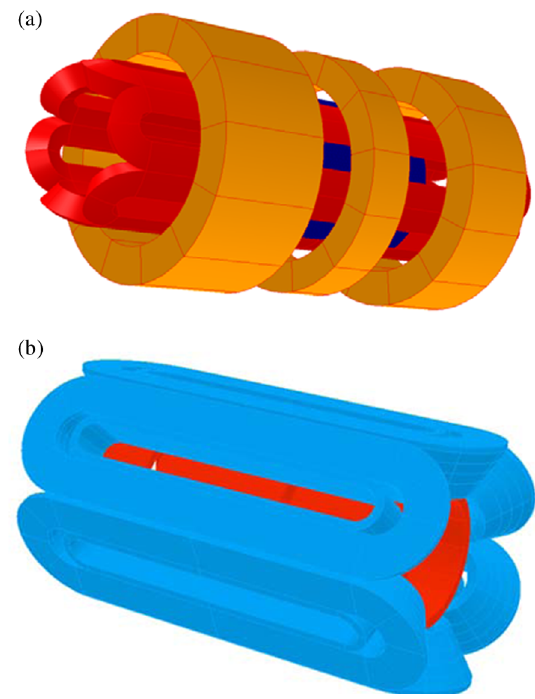
FIG. 5. Magnet coil configuration of the highly charged ECRIS. Classical ECRIS magnet coil configuration of Sext-In- Sol. The SECRAL superconducting magnet coil configuration of Sol-In-Sext.